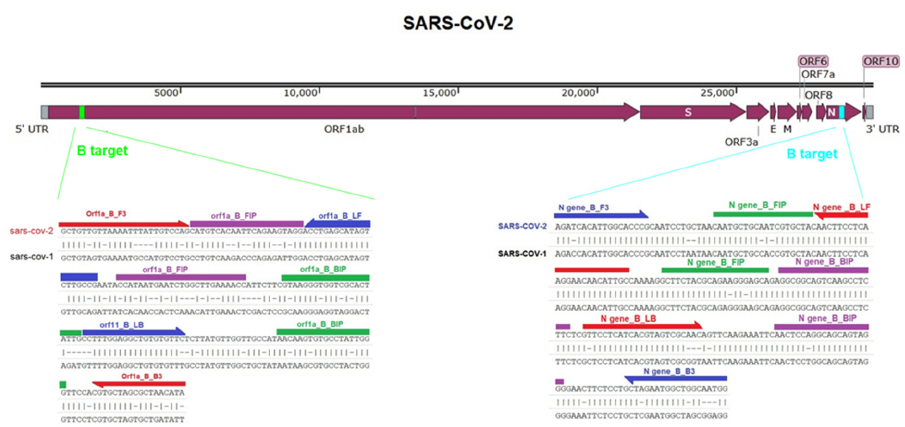
Figure 5. Comparison of the B target in the ORF1a and N gene of SARS-CoV-2 with similar regions in the SARS-CoV-1 genome. The Figure illustrates the location of the B target in the ORF1 and N gene of SARS-CoV-2, which blasted against the SARS-CoV-1 genome sequence. The primers that were used in the RT-LAMP assay were denoted.